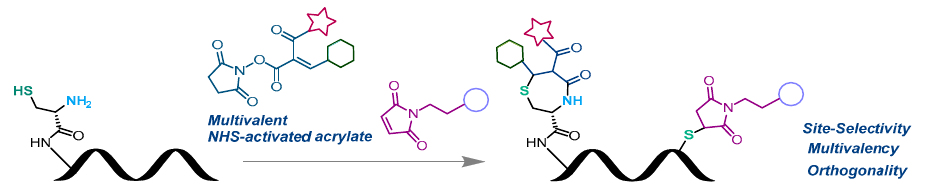
Figure 21. Multivalent NHS-activated acrylate for the site-selective and orthogonal multifunctionalization of peptides.